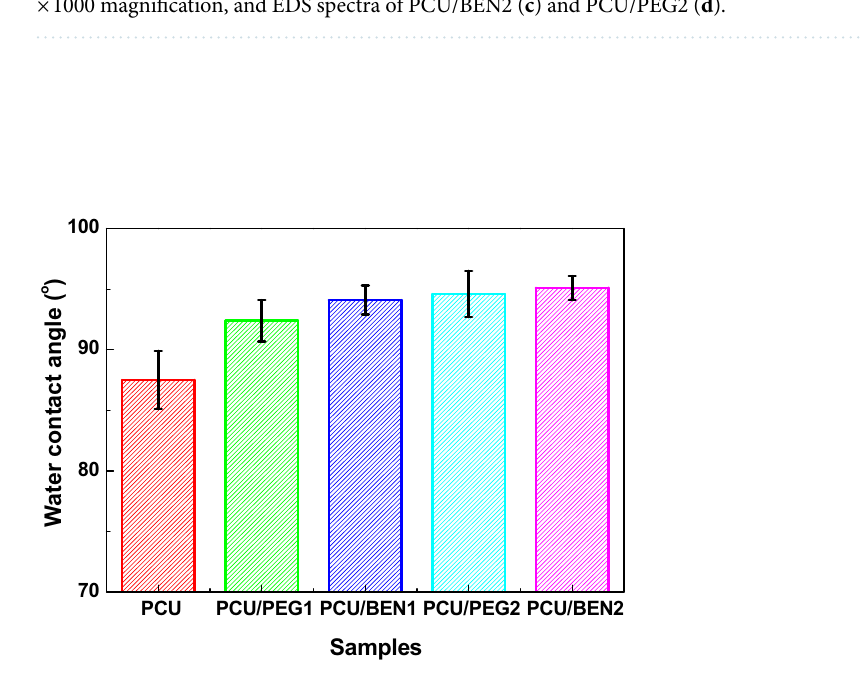
Figure 8. Water contact angles of coating surfaces. PU/1 wt% POSS-PEG nanocomposite (PCU/PEG1), PU/1 wt% POSS-BEN nanocomposite (PCU/BEN1), PU/2 wt% POSS-PEG nanocomposite (PCU/PEG2), PU/2 wt% POSS-BEN nanocomposite (PCU/BEN2) and pure polyurethane